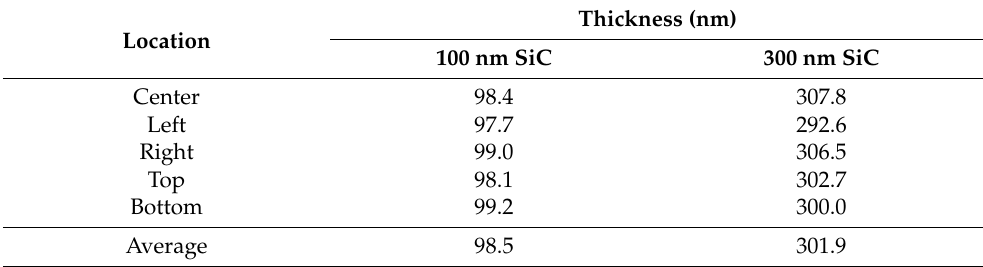
Table 1. The ellipsometry